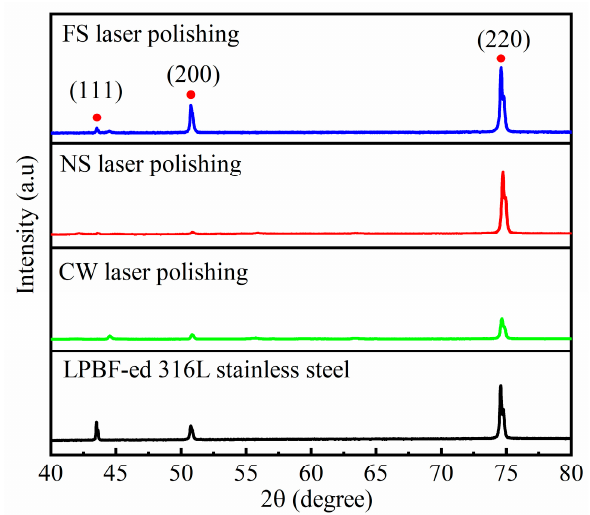
Figure 6. XRD pa tt erns of the LPBF-ed 316L stainless steel before and after laser polishing.